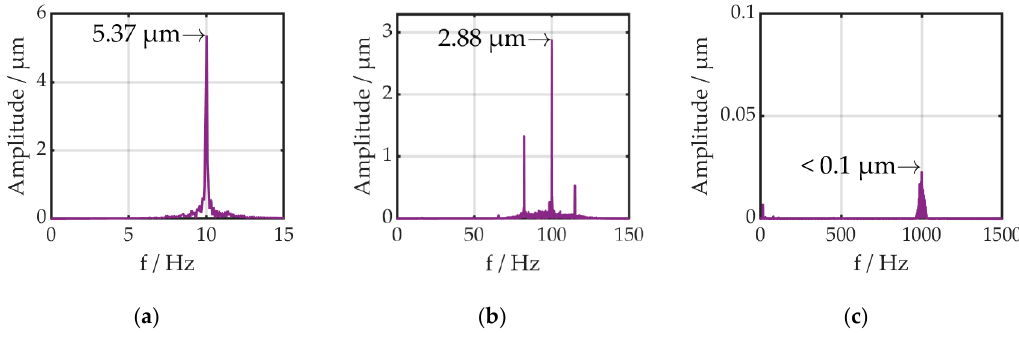
Figure 11. Displacement amplitude with increasing frequency: ( a ) 10 Hz, ( b ) 100 Hz, ( c ) 1000 Hz.